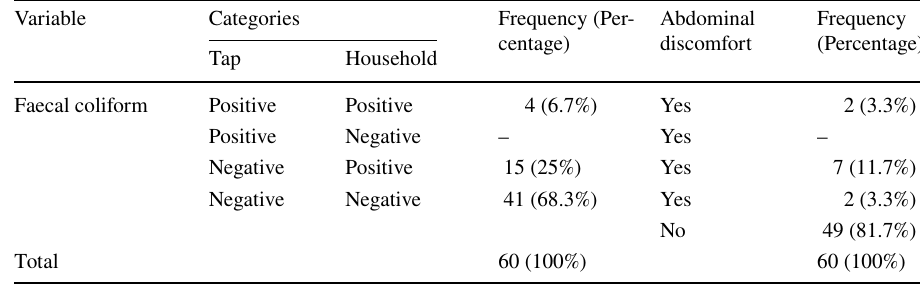
test results from the tap and household water samples computed paired per household to identify specific points of faecal contamination and response of households